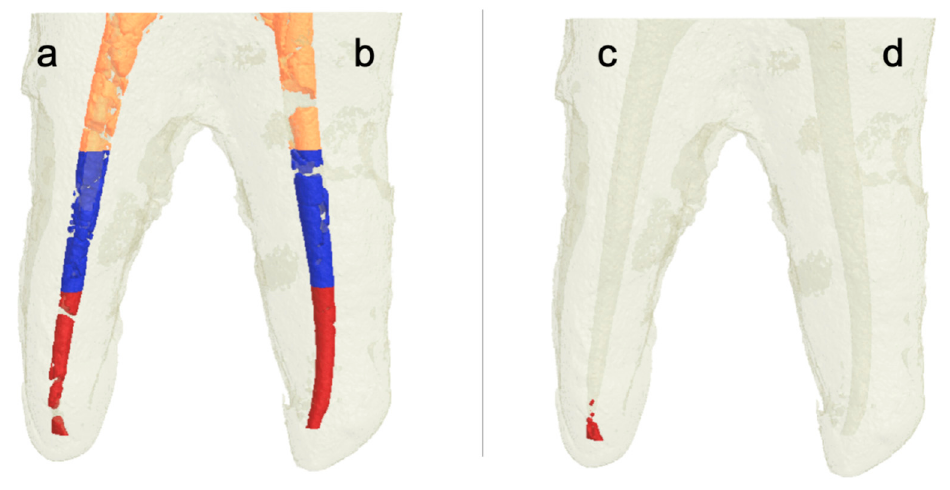
Figure 3. Three-dimensional rendered images constructed from micro-CT scans of root canals filled with Ca(OH) 2 . After placement ( a , b ); and after removal ( c ) XP/SI; and ( d ) XP/PUI). Note that the orange color indicates Ca(OH) 2 in the coronal third, the blue color indicates Ca(OH) 2 in the middle third, and the red color indicates Ca(OH) 2 in the apical third.